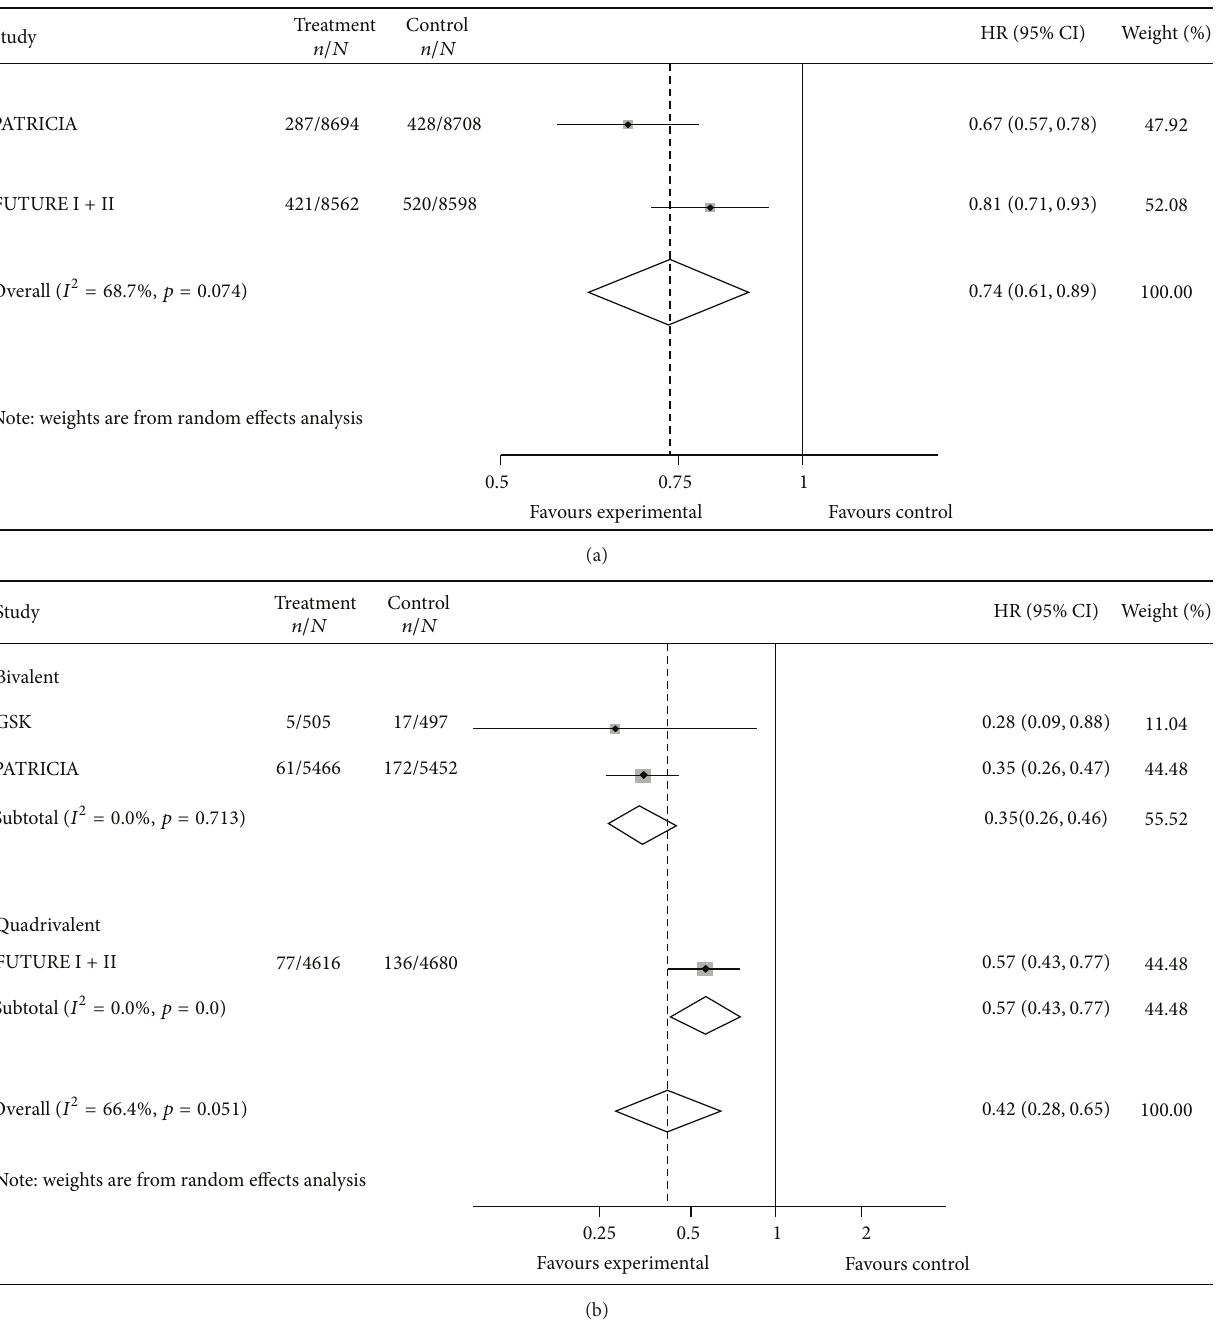
Figure 2: Vaccine efficacy against CIN2+ lesions, in total vaccine (a) and total vaccine na¨ıve cohort (b), any HPV type.